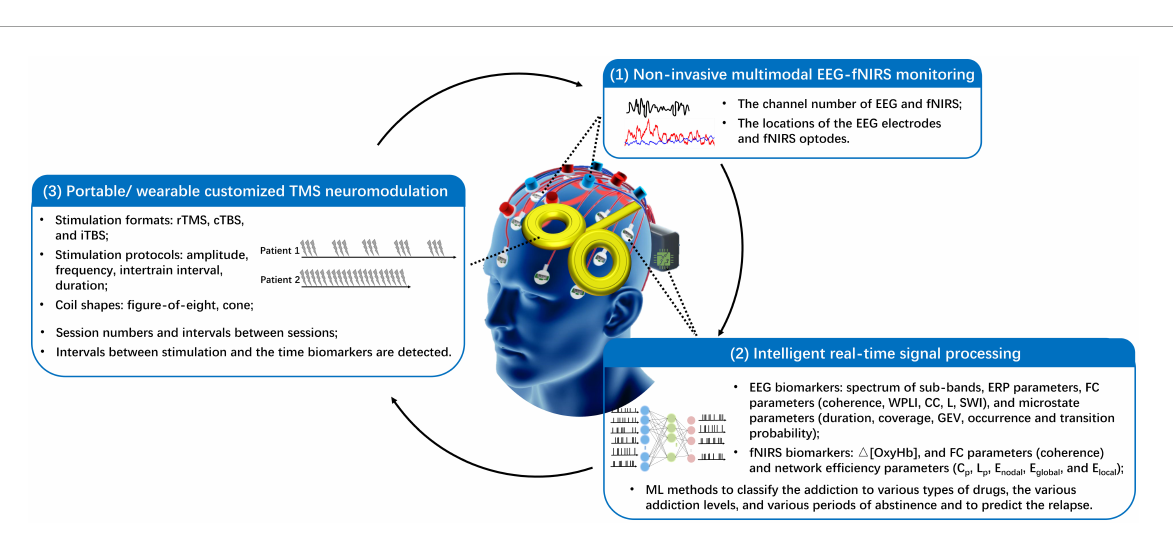
FIGURE4 Proposed intelligent closed-loop TMS neuromodulation to treat methamphetamine addiction. It uses EEG-fNIRS measurements and is composed of three main parts: a real-time brain signal monitoring interface, an artificial intelligence signal processing block, and a customized neuromodulation system. C p and CC, clustering coefficient; cTBS, continuous theta burst stimulation; E global , network global efficiency; E local , local efficiency; E nodal , nodal efficiency; ERP, event-related potential; FC, functional connectivity; GEV, global explained variance; iTBS, intermittent theta burst